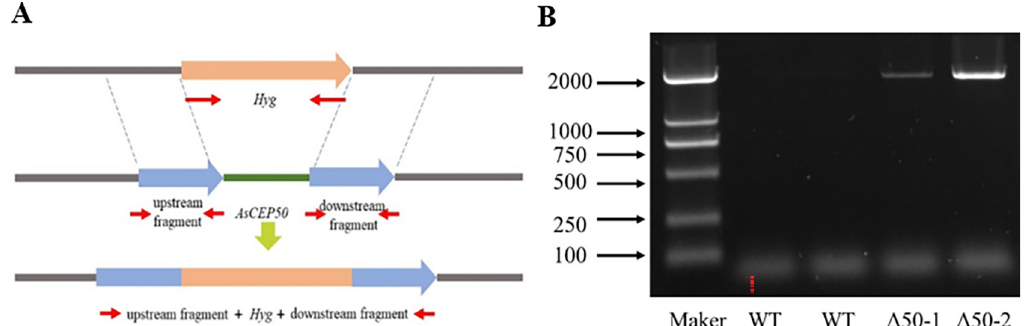
Fig 4. AsCEP50 gene replacement and PCR screening of mutants. ( A ) The diagram of homologous recombination of AsCEP50 and Hyg gene. ( B ) Verification of Hyg gene in the genomes of wild-type and Δ 50 mutant strains.